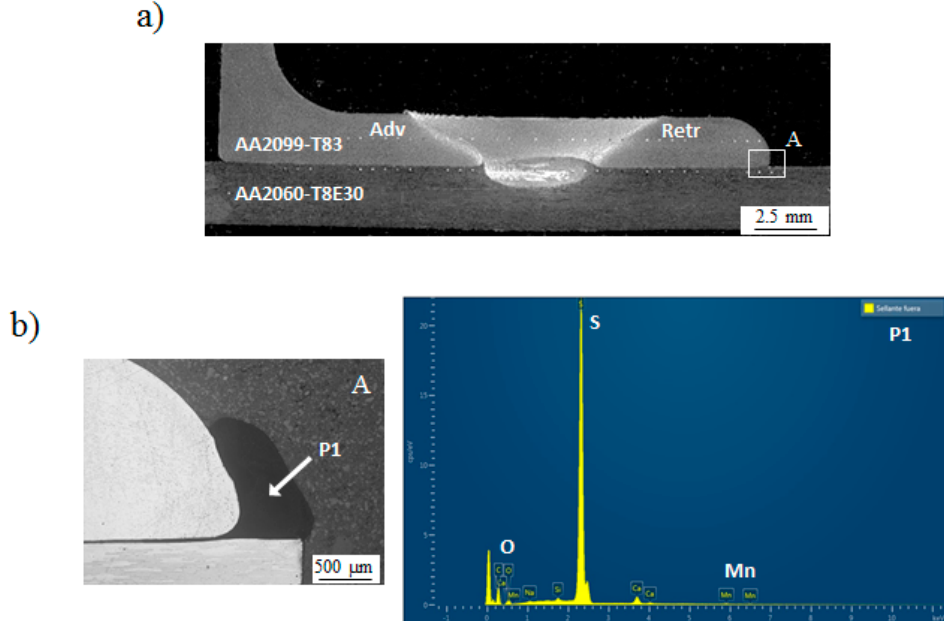
Figure 10. ( a ) Cross-sectional macrograph of the FSW weld from coupon C6 and ( b ) detail of the region indicated as detail A in Figure 10a and EDS analysis of the sealant.